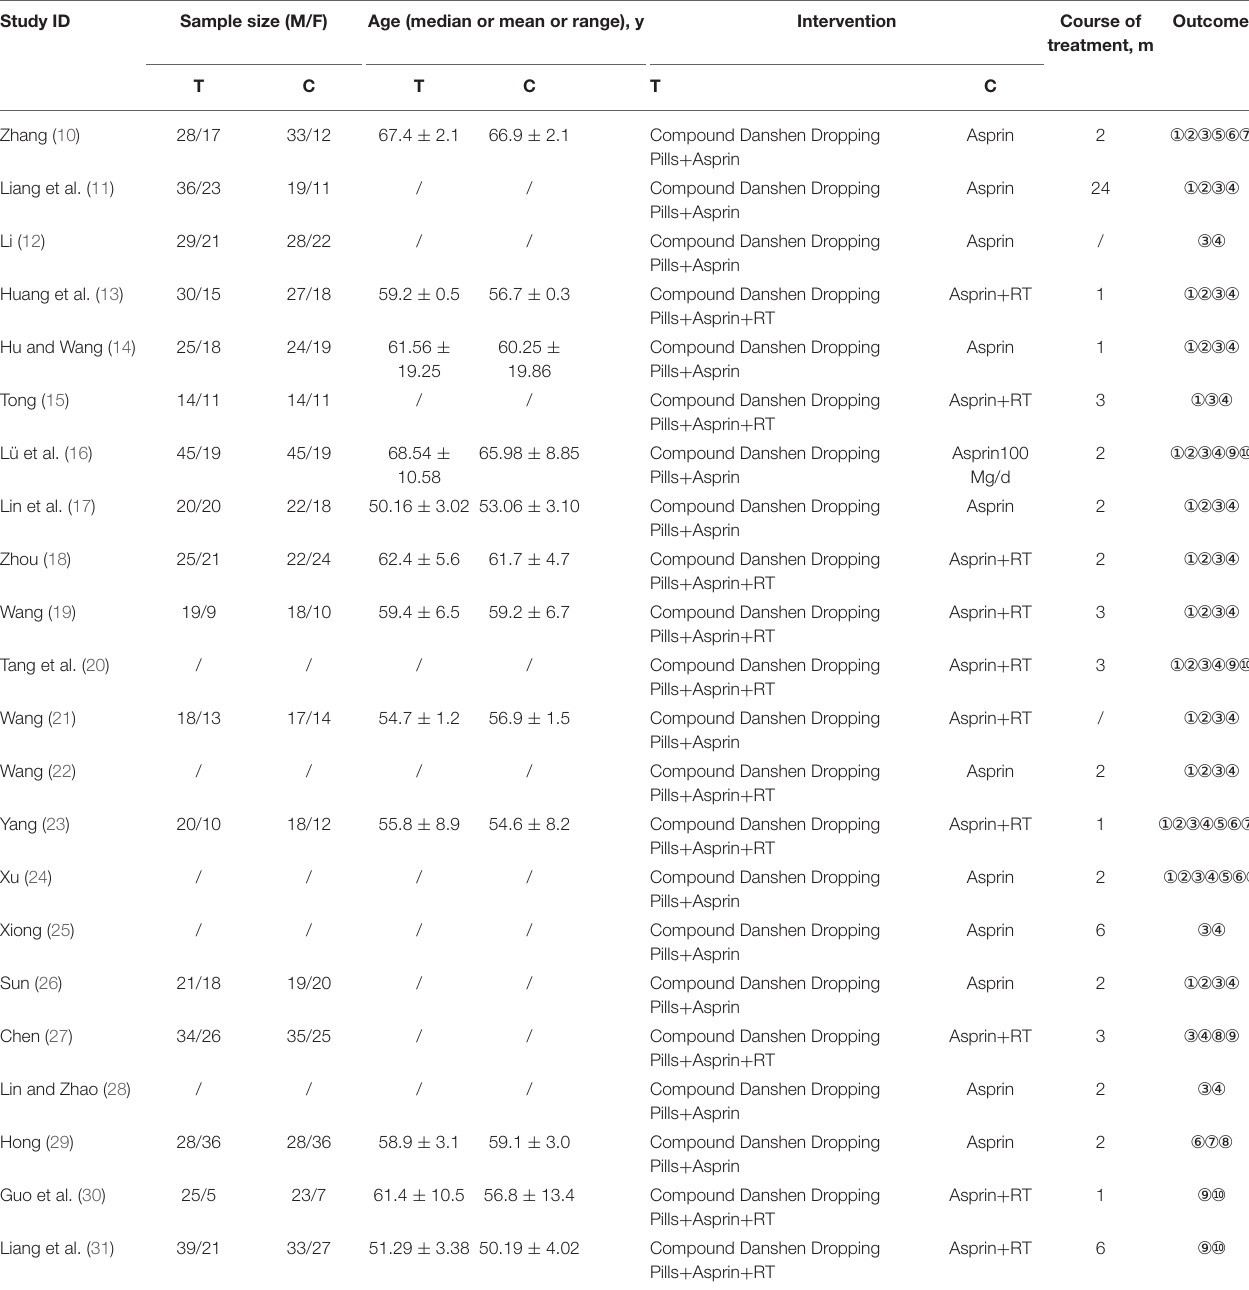
TABLE 1 | Characteristics of the included